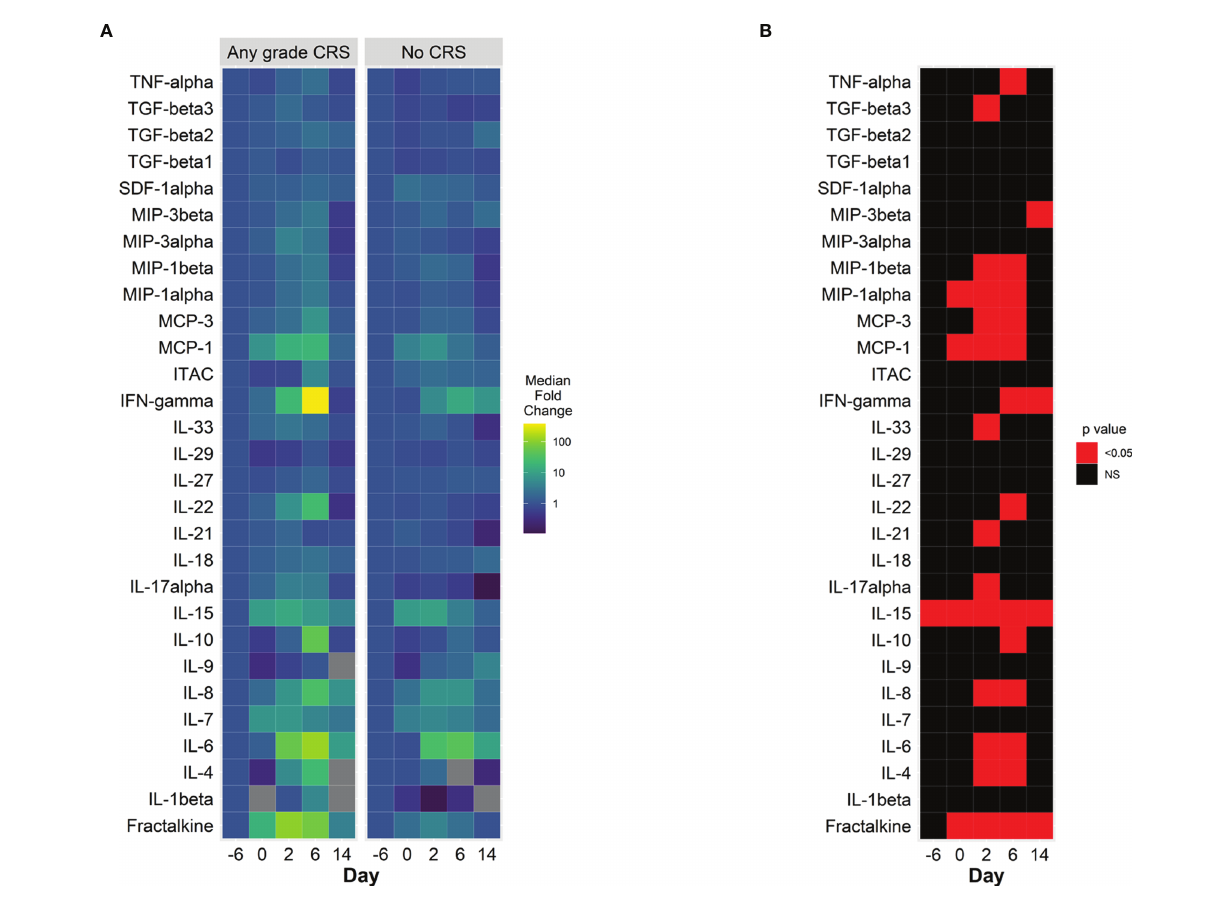
FIGURE 2 | Cytokine changes in CAR-T cell patients treated with prophylactic tocilizumab, (n = 13). (A) Median fold change from baseline (pre-lymphodepletion) over time in plasma cytokine concentrations in patients with CRS (left panel) and without CRS (right panel). Days are represented on the horizontal axis. Larger increases from baseline are shown in the green – yellow spectrum. Gray tiles represent missing values. (B) Comparisons of mean plasma cytokine concentrations of patients with CRS and without CRS (Wilcoxon test). Red tiles denote p values < 0.05. Not signi fi cant values (NS) are noted with black